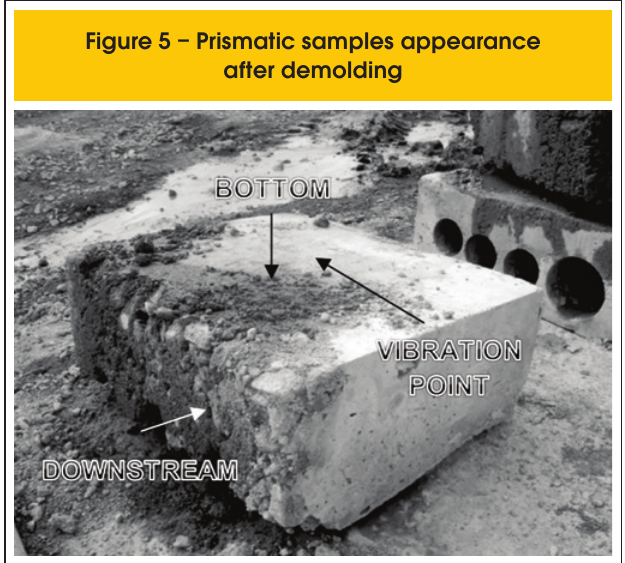
Figure 7 – Splitting tensile strength